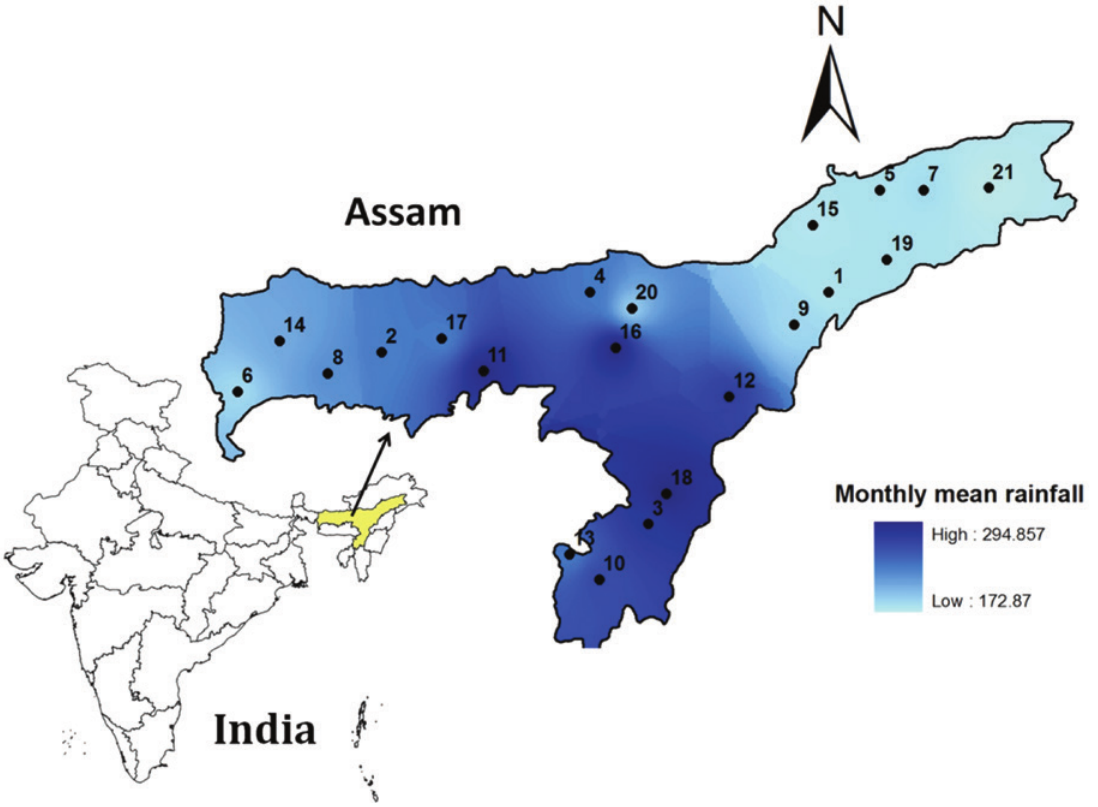
Figure 1: Location of Assam and Stations on India Map, and Distribution of Monthly Mean Rainfall over Assam. The numbers represent the